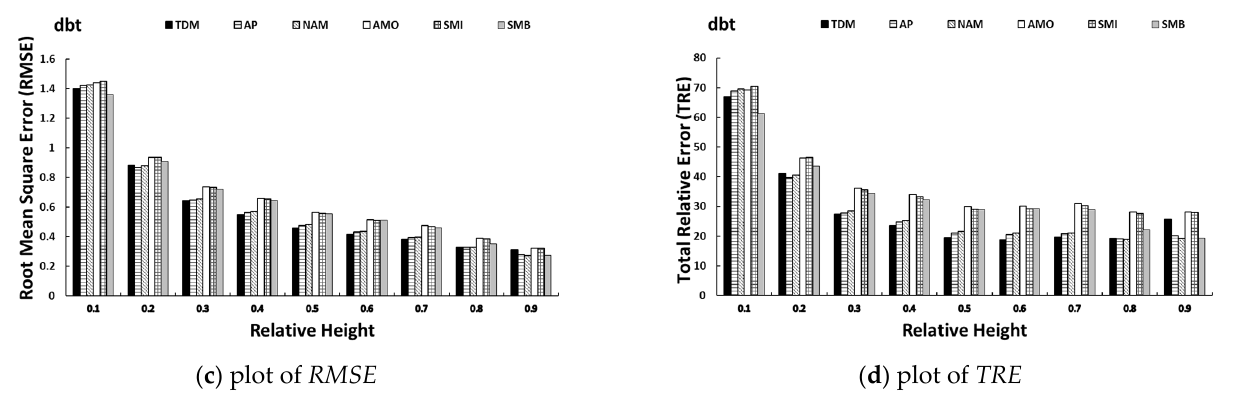
( c ) plot of RMSE ( d ) plot of TRE Figure 5 . Plots of evaluation statistics from six methods against relative height classes for dbt.